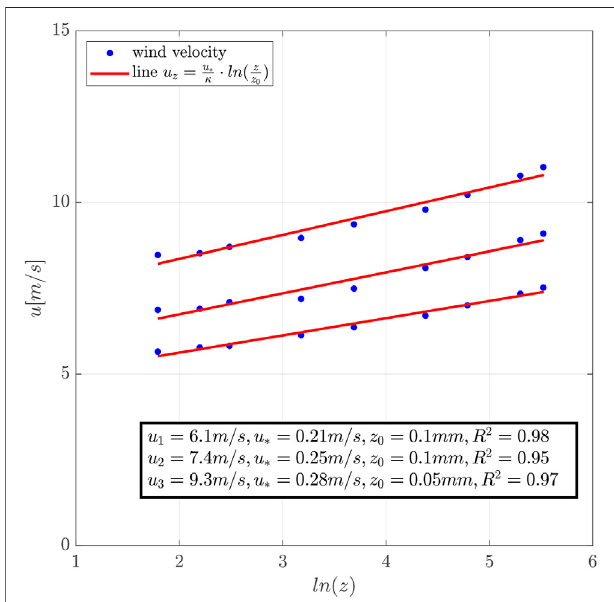
FIGURE5| Examplesofthevelocitypro fi lefor u 1 =6.1 m/s, u 2 =7.4 m/s, and u 3 = 9.3 m/s. The blue dots represent the measured wind velocity and the red lines indicate the regression lines, see Eq. 7